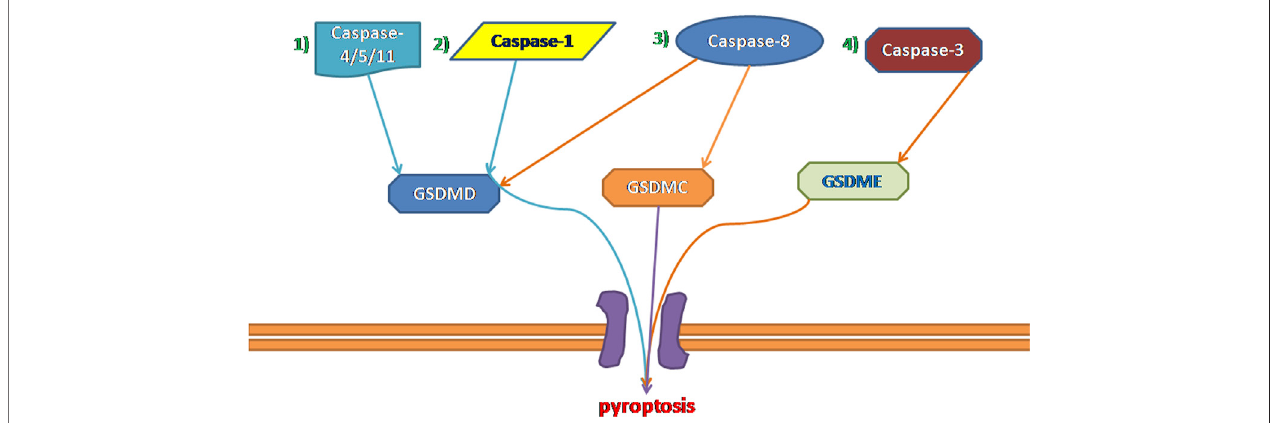
FIGURE 1 | Four types of pyroptosis: 1) Non-canonical In fl ammasome Pathways Associated With Pyroptosis. 2) canonical In fl ammasome Pathways Associated With Pyroptosis. 3) Caspase-8-dependent pyroptosis pathway. 4) Caspase-3-dependent pyroptosis pathway.